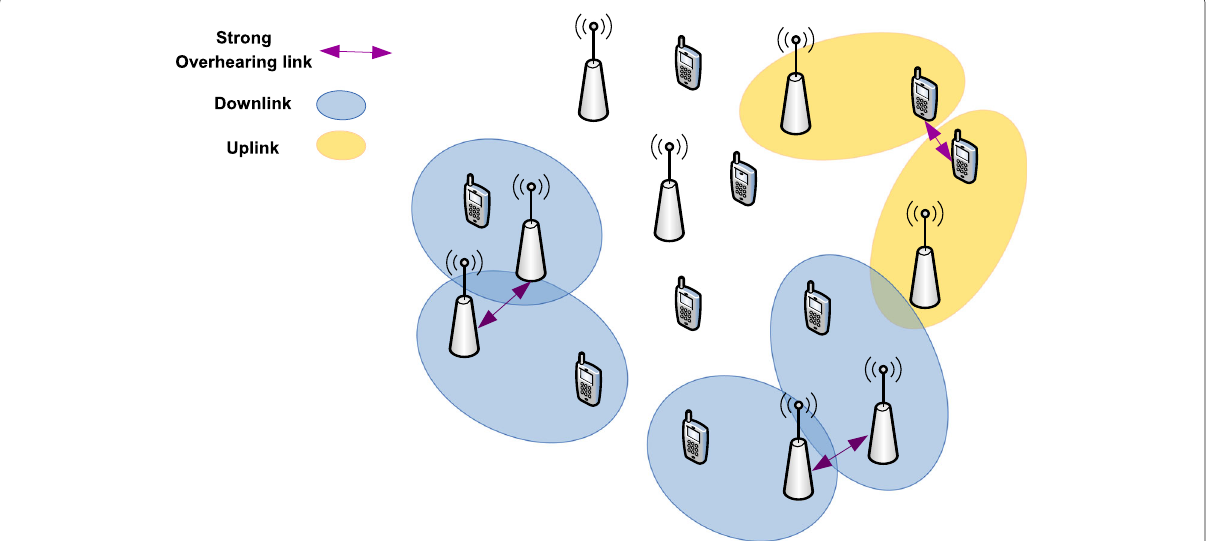
Fig. 1 Exploiting the strong overhearing link in dense networks for downlink and uplink